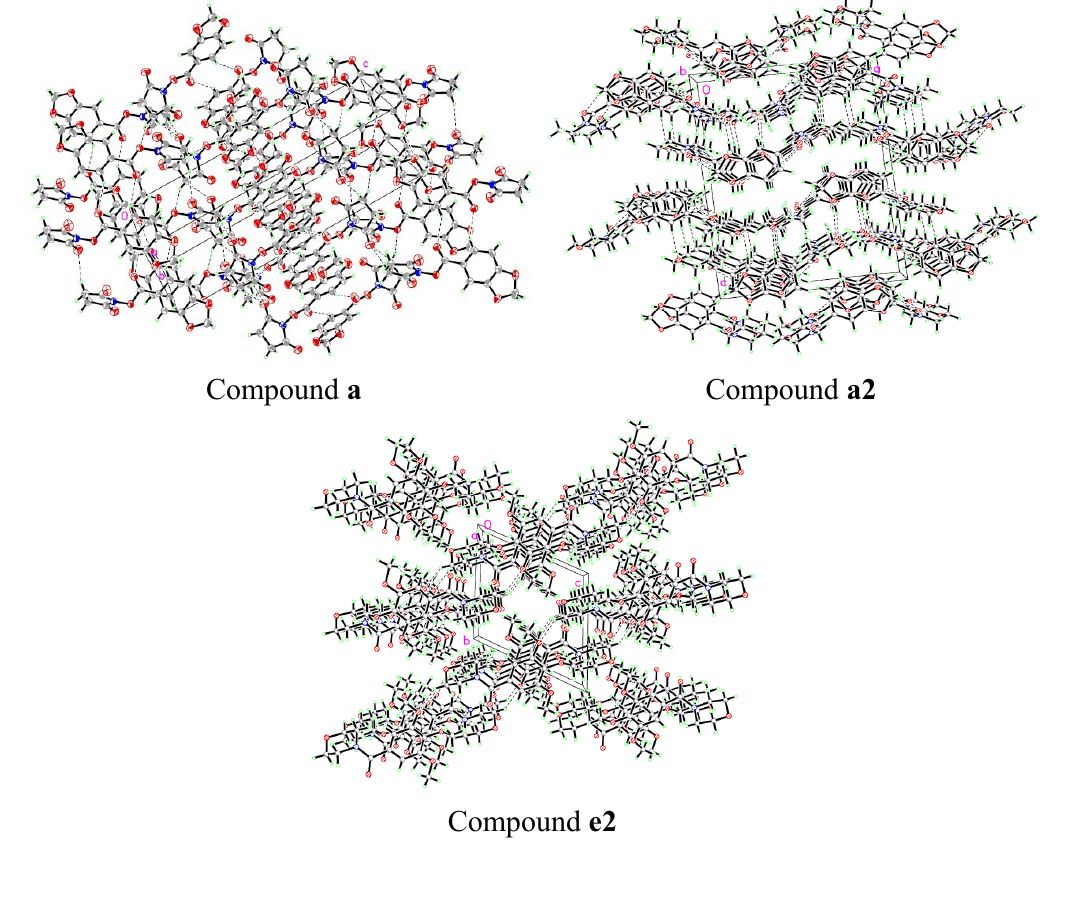
Figure 3. View of the molecular packing in a , a2 and e2